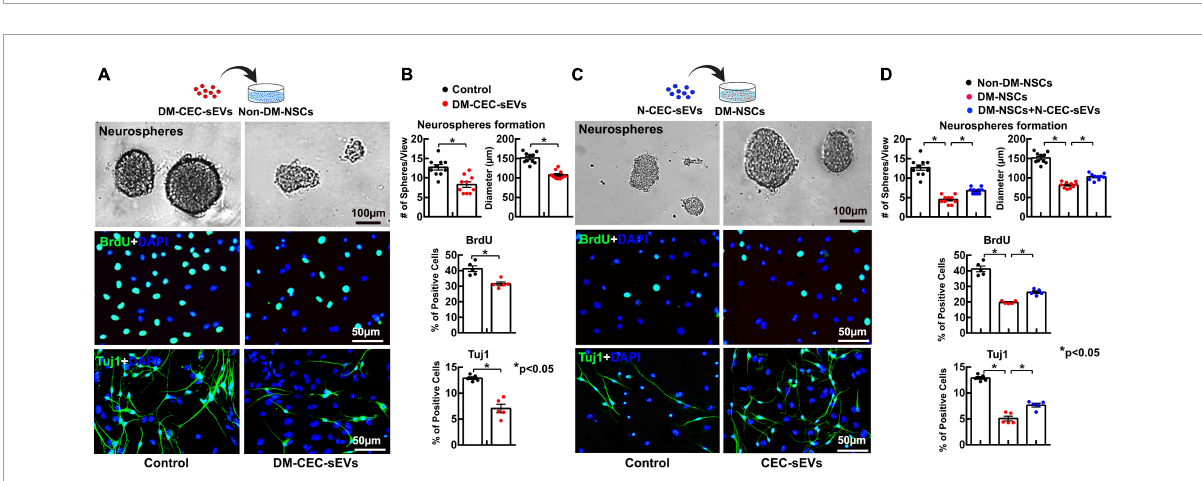
FIGURE2 The effects of DM-CEC-sEVs and N-CEC-sEVs on NSCs. The schematic outlines the experimental protocol for the effect of DM-CEC-sEVs on healthy non-DM-NSCs and the representative images of non-DM-NSCs culture (A) . Quantitative data show DM-CEC-sEVs reduced the number and size of neurospheres, BrdU (green) positive cells, and Tuj1 (green) positive cells (B) . The schematic outlines the experimental protocol for the effect of N-CEC-sEVs on DM-NSCs and the representative images of DM-NSCs culture (C) . Quantitative data show N-CEC-sEVs increased number and size of neurospheres, BrdU positive cells, and Tuj1 positive cells (D) . * p < 0.05 versus indicated